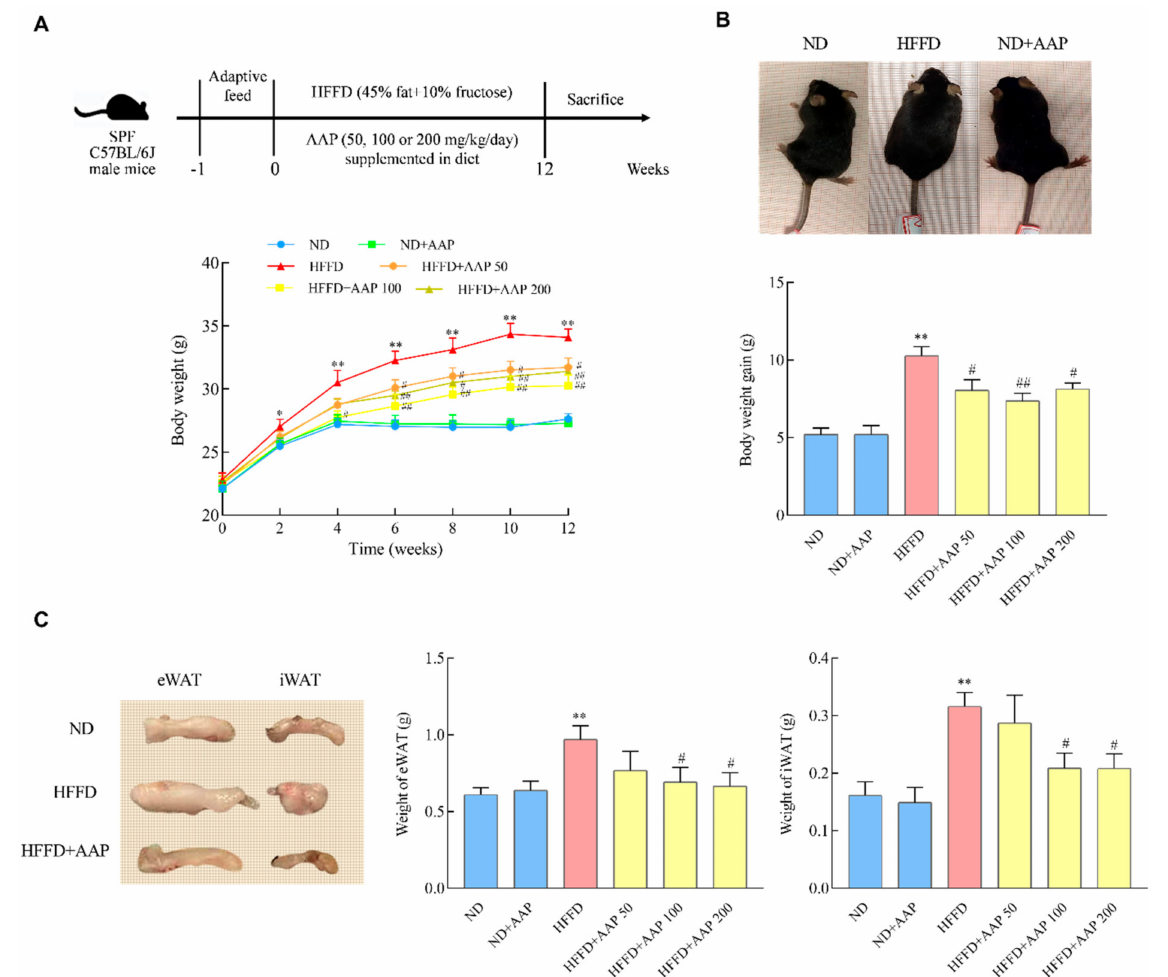
Figure 1. The effects of Auricularia auricula-judae polysaccharides on HFFD induced mice body weight and fat accumulation. Seven-week-old male C57BL/6J mice were randomized into 6 groups ( n = 10 per group): ND, ND + AAP, HFFD, and HFFD + AAP ( Auricularia auricula-judae polysaccha- ride, 50, 100, 200 mg/kg/day, in feed) for 12 weeks. ( A ) Above: Timeline of C57BL/6J mice with AAP and/or HFFD treatment; Below: Body weight; ( B ) Above: Representative mouse pictures after 12 weeks feeding; Below: Body weight gain; ( C ) Weight of subcutaneous fat and epididymal fat. The data are presented as the mean ± SEM, * p < 0.05, ** p < 0.01, vs. ND group, # p < 0.05, ## p < 0.01 vs. HFFD